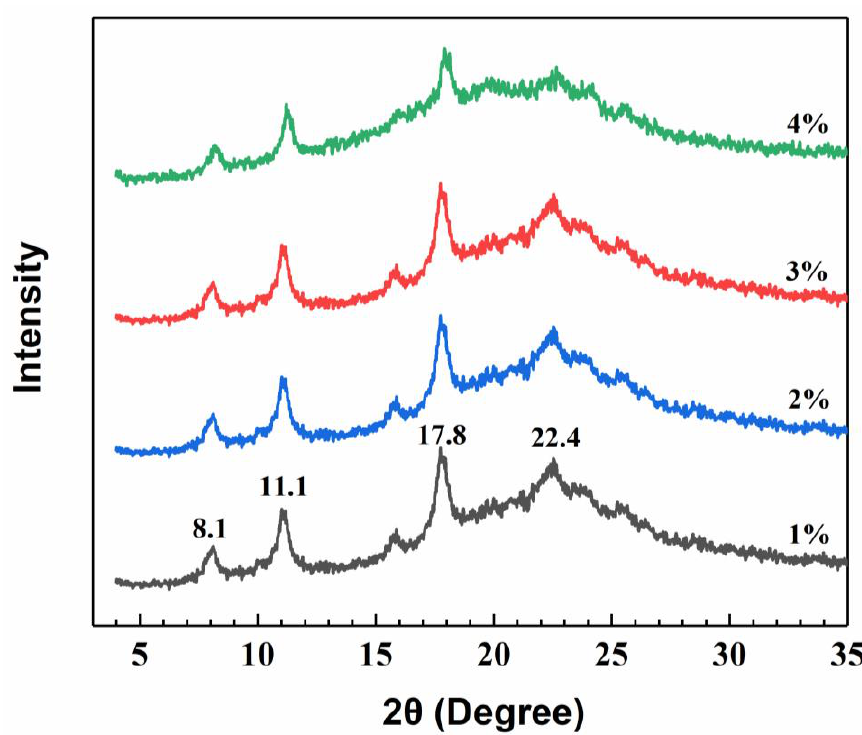
Figure 3. XRD patterns of chitosan films.